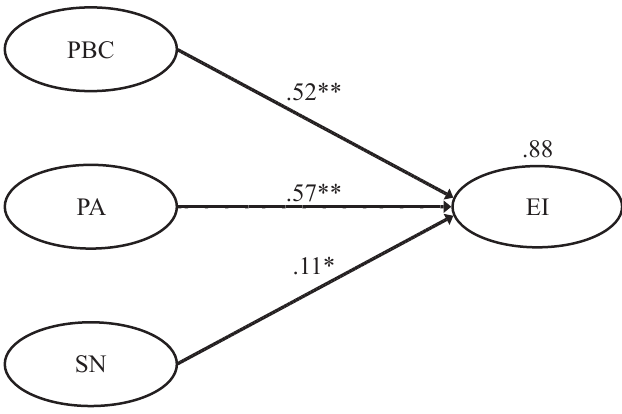
Figure 1. Standardized estimates of the structural